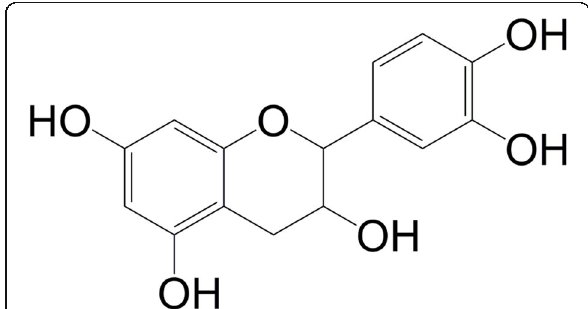
Fig. 1 Structure of (+)-catechin isolated from a hydro-methanolic extract of the bark of A.